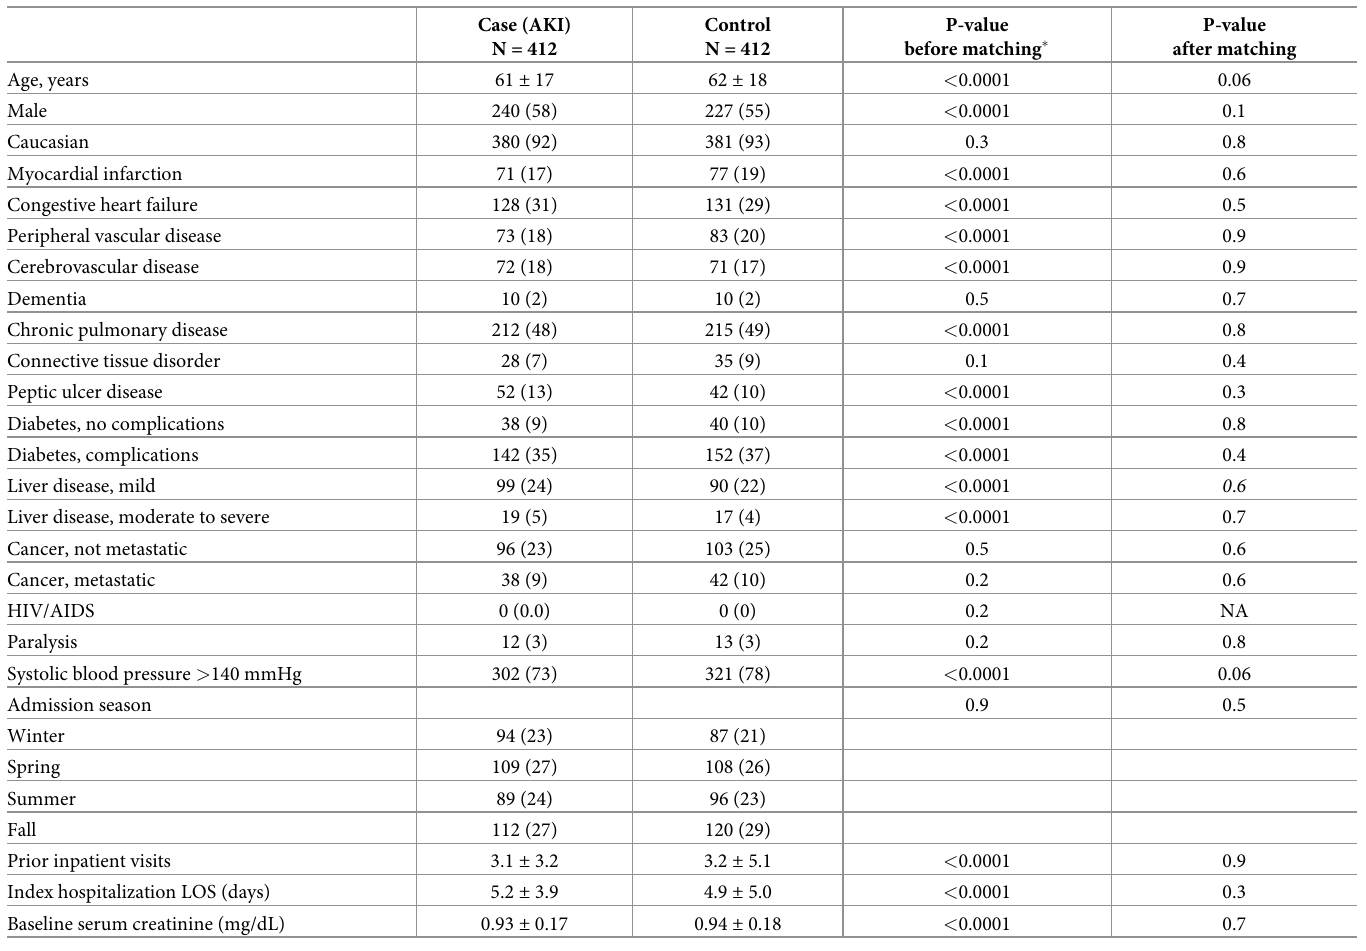
Table 1. Baseline characteristics of study participants after propensity-score